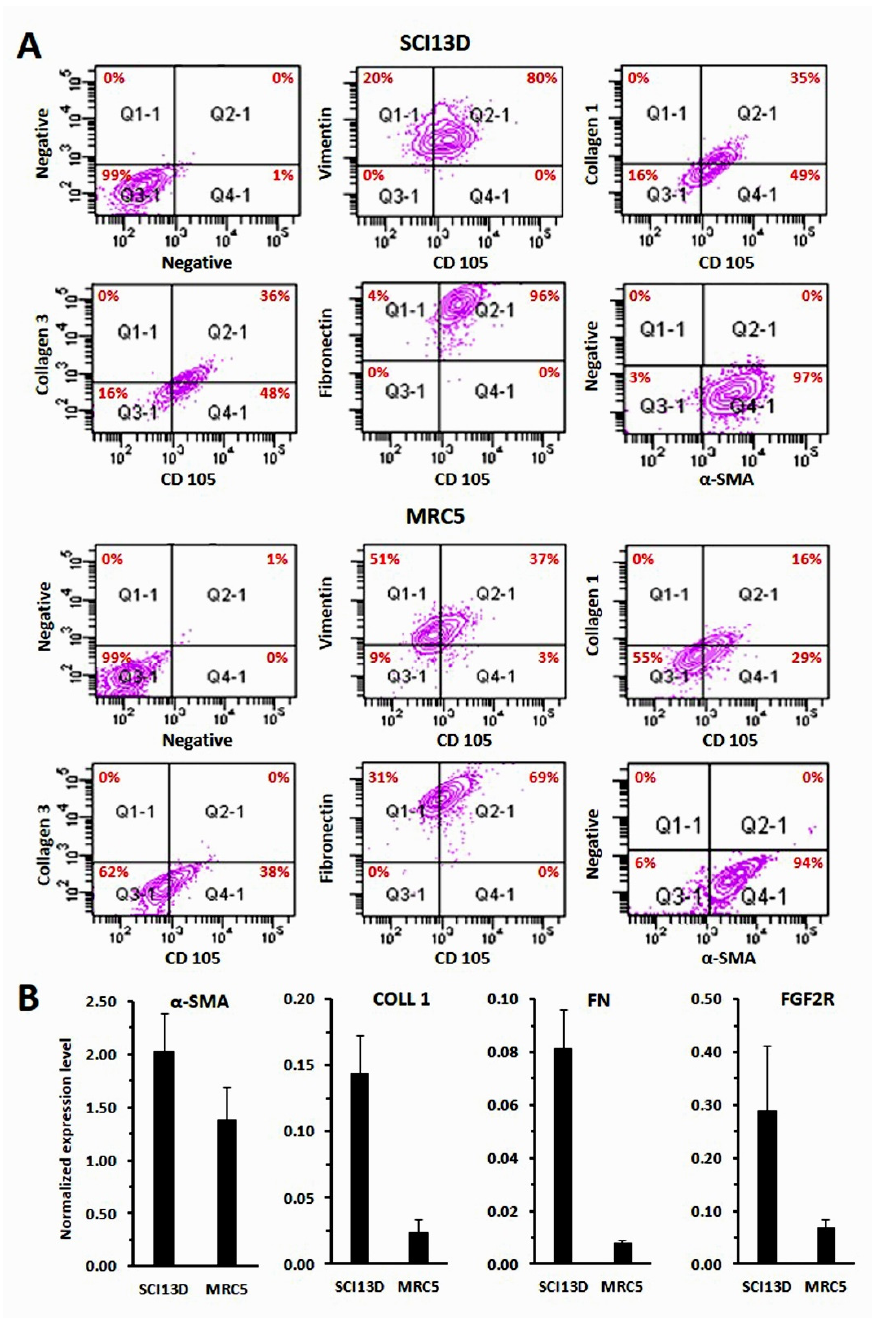
Figure 4. Cyto-fluorographic and RT-PCR determination of typical markers of fibroblasts/myofibroblasts in SCI13D and in MRC5 control cell line. ( A ) Membrane (CD105) and intracytoplasmic detection of vimentin, collagen-1, collagen-3, and α -smooth muscle actin (SMA) in SCI13D as compared with MRC5 cell line, both evaluated at passage 3; ( B ) quantification of mRNA expression levels of α -SMA, type 1 collagen (Coll 1), fibronectin (FN), and FGFR2 in SCI13D with respect to MRC5. Histograms depict normalized average values ± SD of three determinations.